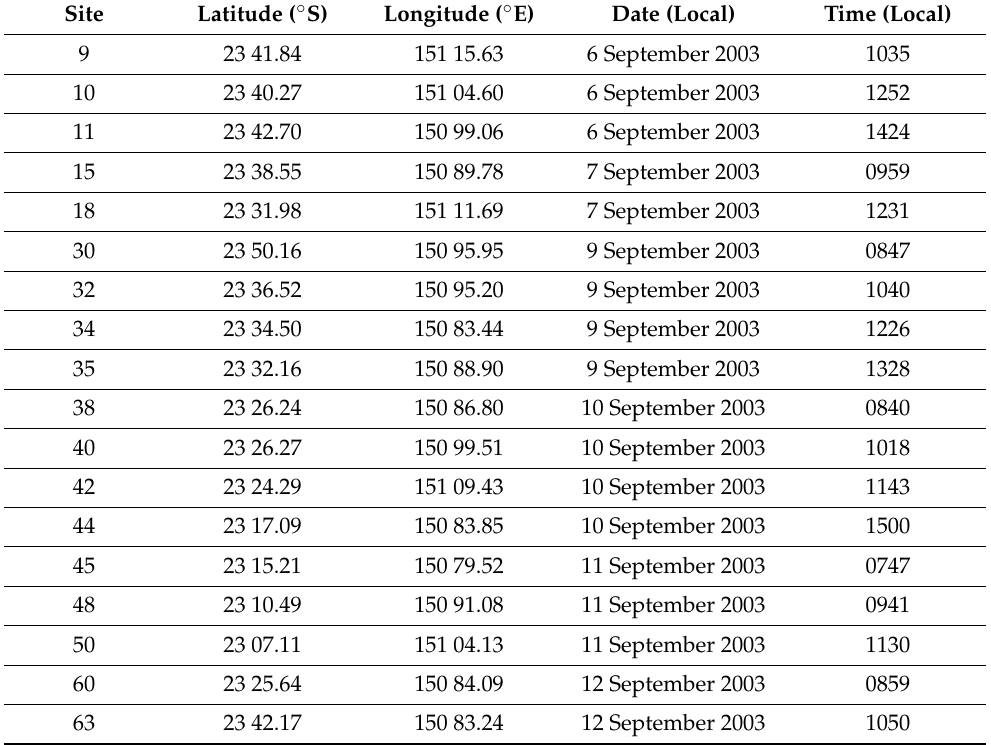
Table 1. Meta data for sites sampled within Keppel Bay. Date and time are in local time (Australian Eastern Standard Time; UTC +